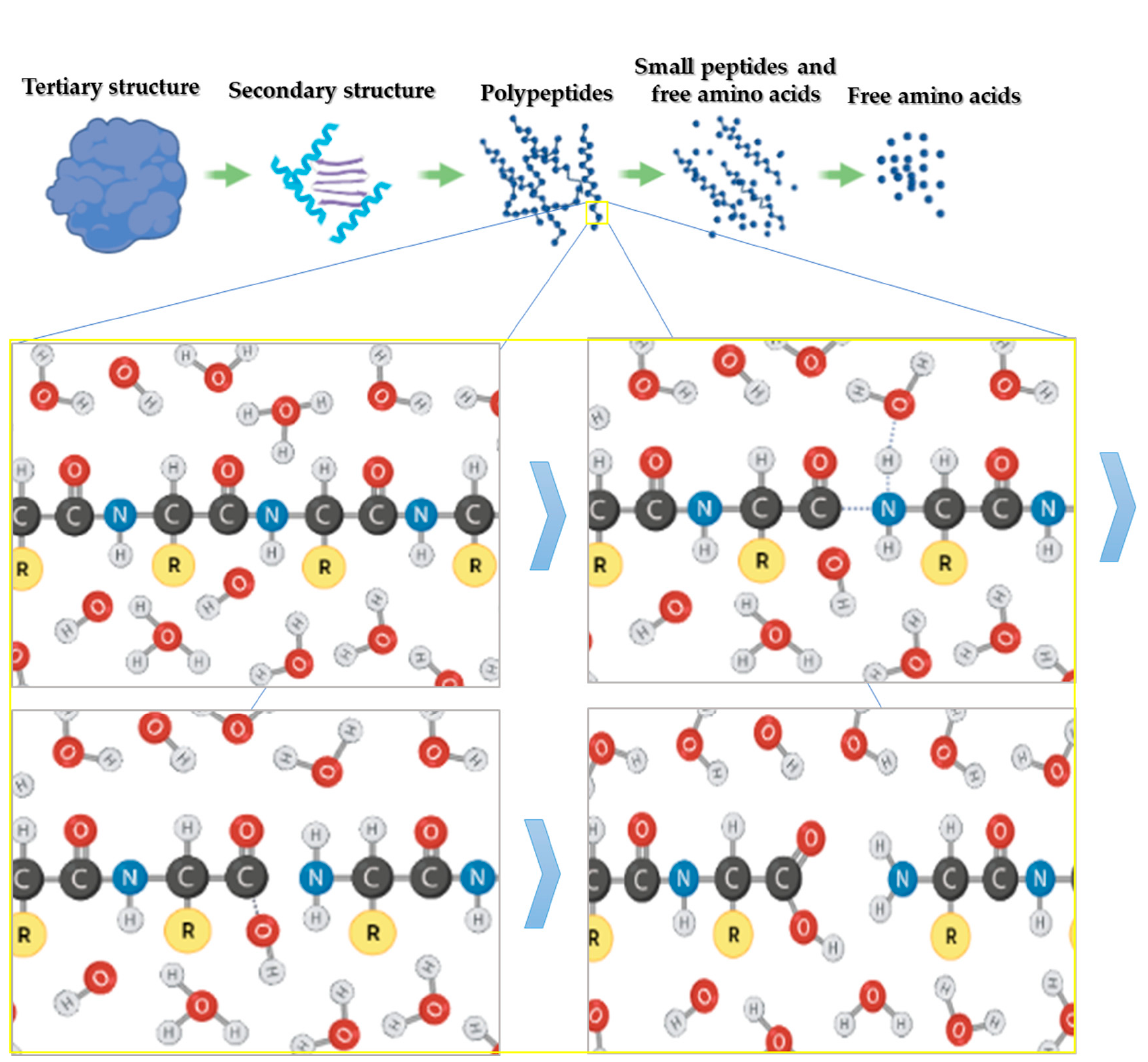
Figure 2. Scheme of protein hydrolysis mechanism of subcritical water.